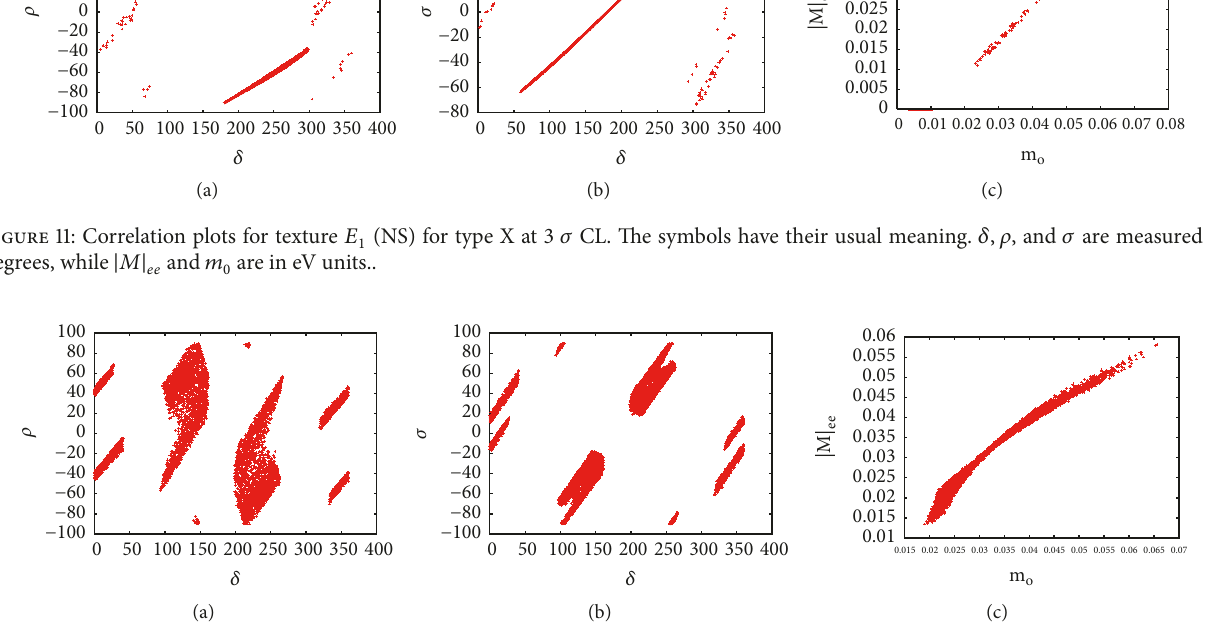
Figure 12: Correlation plots for texture 𝐸 1 (IS) for type Y at 3 𝜎 CL. The symbols have their usual meaning. 𝛿, 𝜌 , and 𝜎 are measured in degrees, while |𝑀| 𝑒𝑒 and 𝑚 0 are in eV